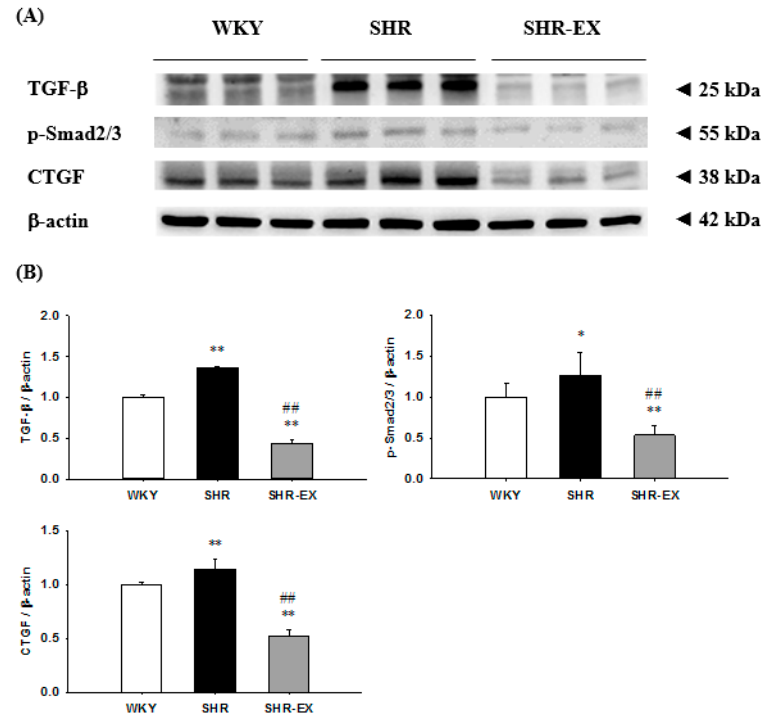
Figure 4. ( A ) The representative protein products of transforming growth factor-beta (TGF- β ), phospho-Smad2/3 (p-Smad2/3), and connective tissue growth factor (CTGF) extracted from the renal cortex of excised kidneys of Wistar-Kyoto rats (WKY), sedentary spontaneously hypertensive rats (SHR), and spontaneously hypertensive rats with exercise training (SHR-EX), as measured by Western blotting analysis; ( B ) the bars represent the relative protein quantification of TGF- β , p-Smad2/3, and CTGF on the basis of β -actin and indicate mean values ± SD (n = 8 in each group). * p < 0.05 and ** p < 0.01 significant difference compared with WKY. ## p < 0.01 significant difference between the SHR group and SHR-EX group.